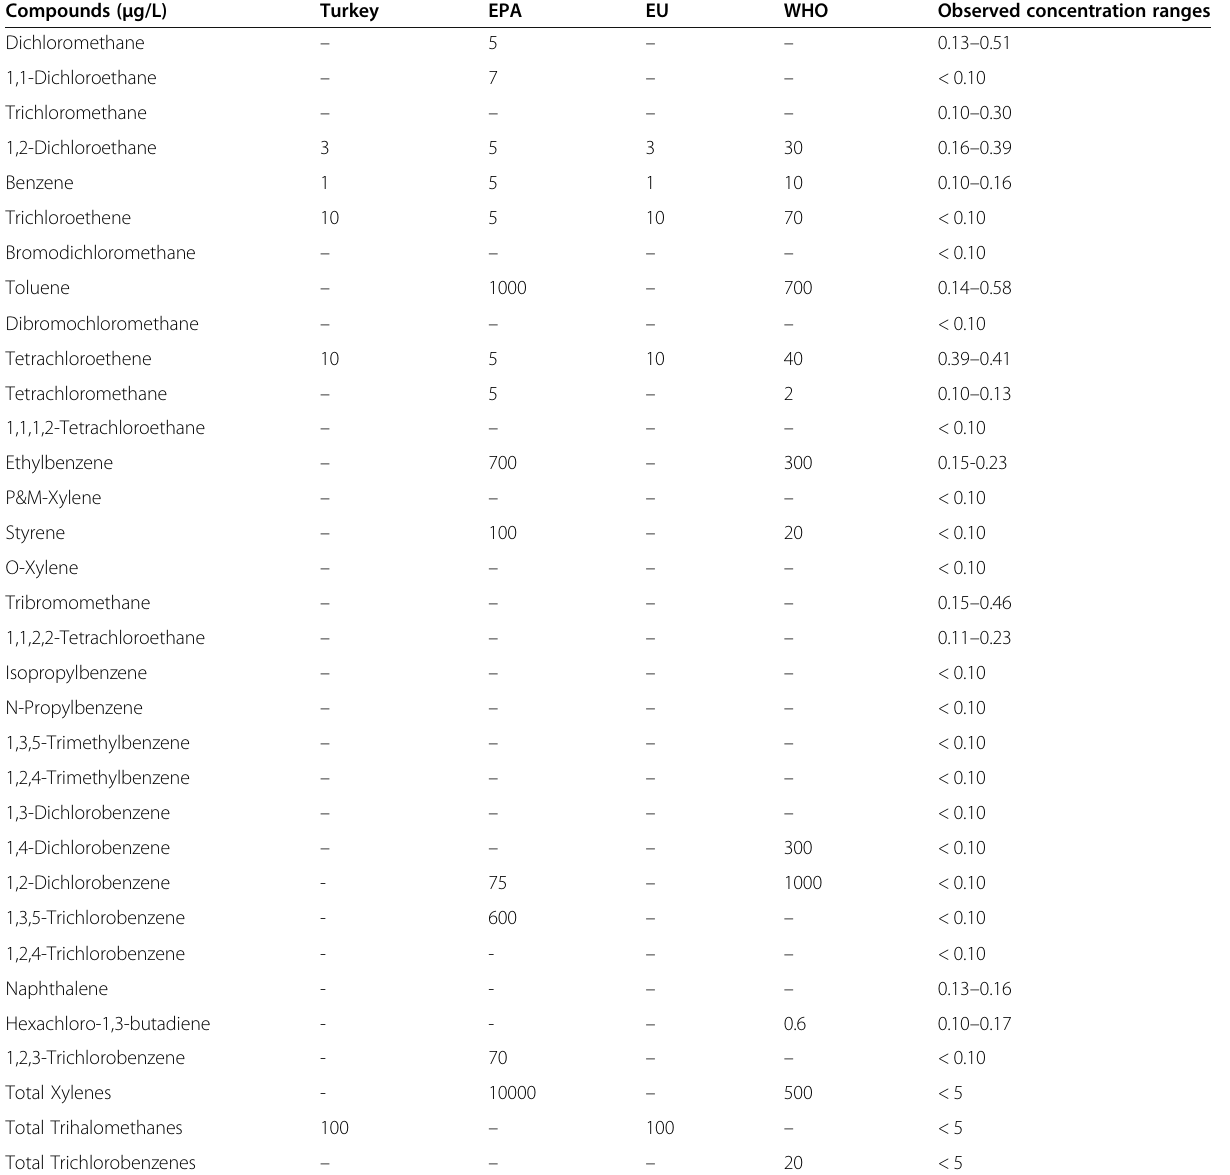
Table 6 Limit values of national and international regulations for VOCs and their observed concentration ranges in the drinking water samples (EU 1998; RCWHC 2005; WHO 1993; WHO 2001) Compounds ( μ